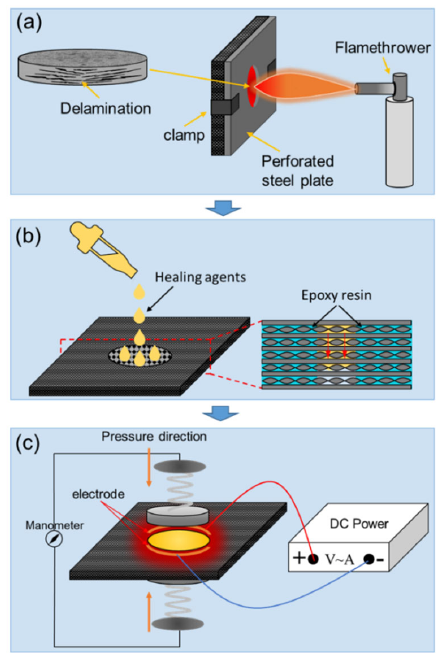
Figure 1. Schematic of the in situ thermal ablation repair process. ( a ) Damage removal by the combustion process. ( b ) Filling the healing agent in the damaged region. ( c ) Resin solidification assisted by the electric resistance heating.